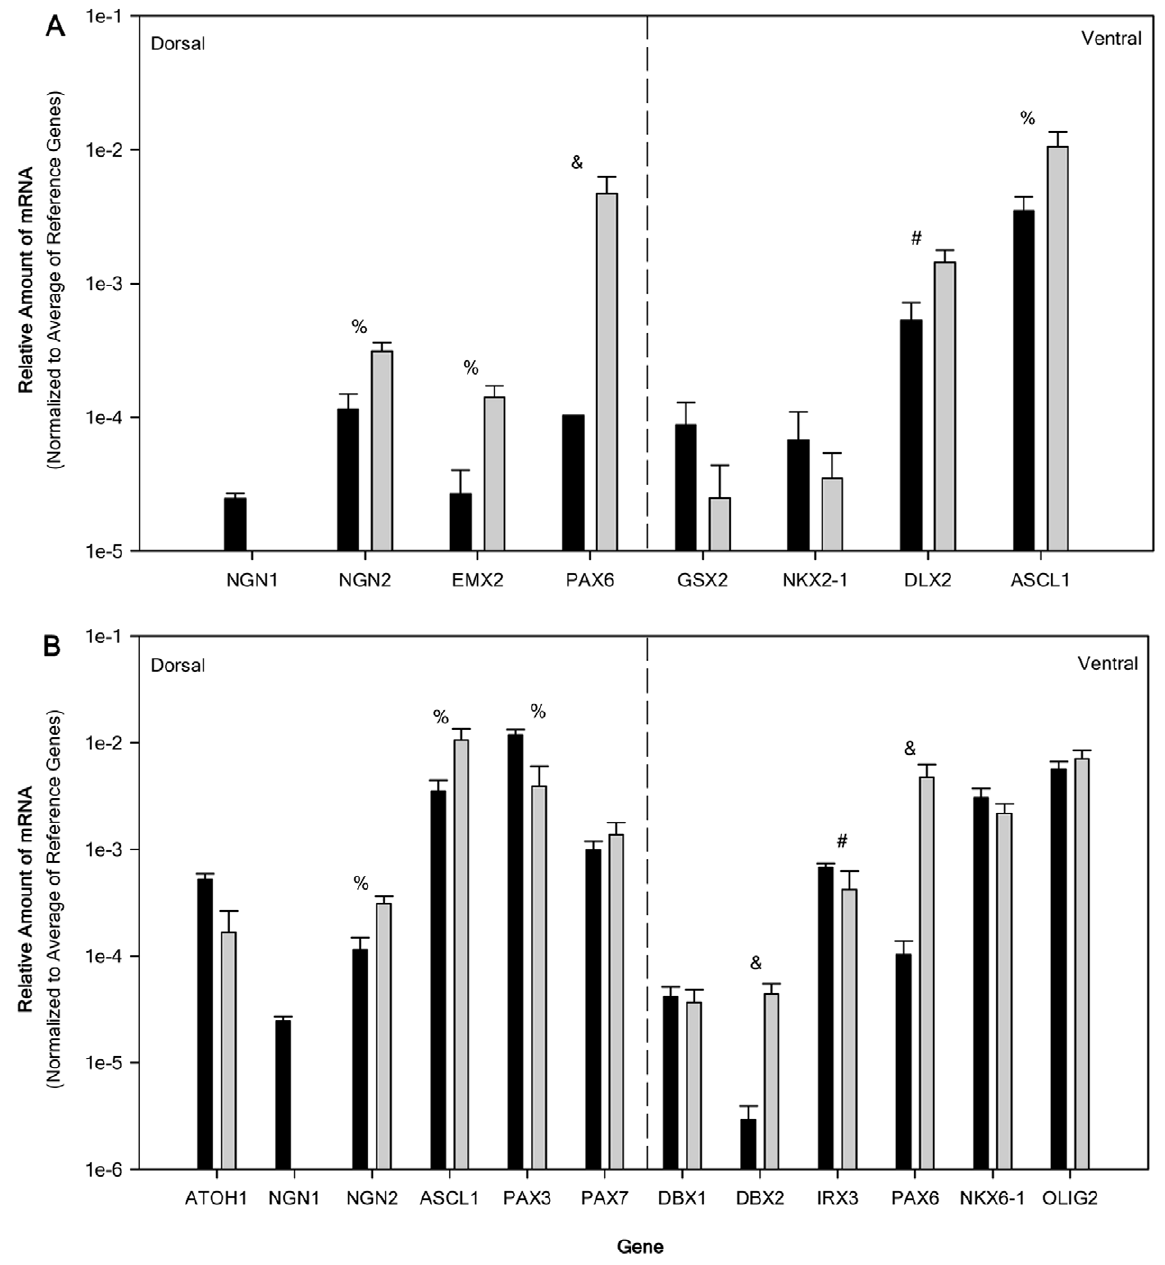
Figure 6. Relative mRNA expression of regional specific transcription factor genes in the dorsoventral direction for NTERA2 (NT2) cells and purified NTERA2 all-trans retinoic acid differentiated neurons (NT2N). Relative amounts of mRNA normalized to the average of 3 reference genes (G3PDH, PPIA, and NUBP1). Relative amount of mRNA for NT2 (black bar) and NT2N (gray bars) were obtained from 6 passage matched cultures (ranging from 25–36) and all samples were analyzed independently in triplicate. Panel A displays the relative expression from the telencephalon and panel B from the spinal cord in a dorsal to ventral order. Dashed line divide dorsal and ventral genes. All data are expressed as the average relative gene expression + SEM. For the comparison of NT2 to NT2N: # p , 0.05, % , p , 0.01, and & p ,